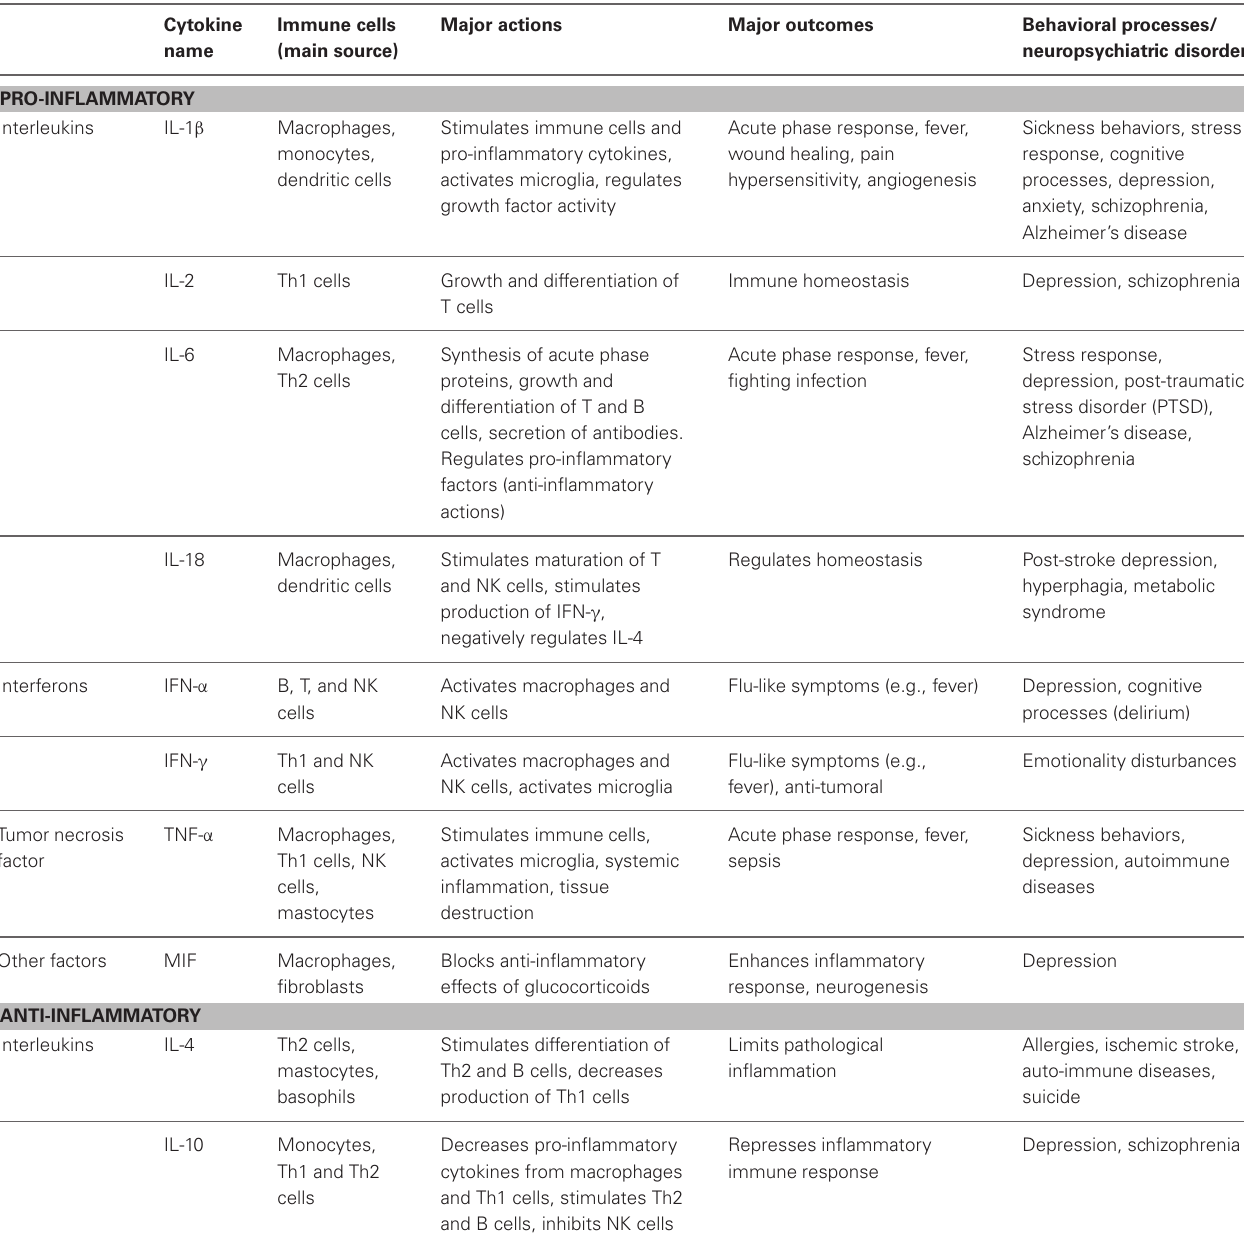
Table 1 | Subset of pro- and anti-inflammatory cytokines that had been implicated in depressive illnesses: potential roles in behavioral processes and/or neuropsychiatric